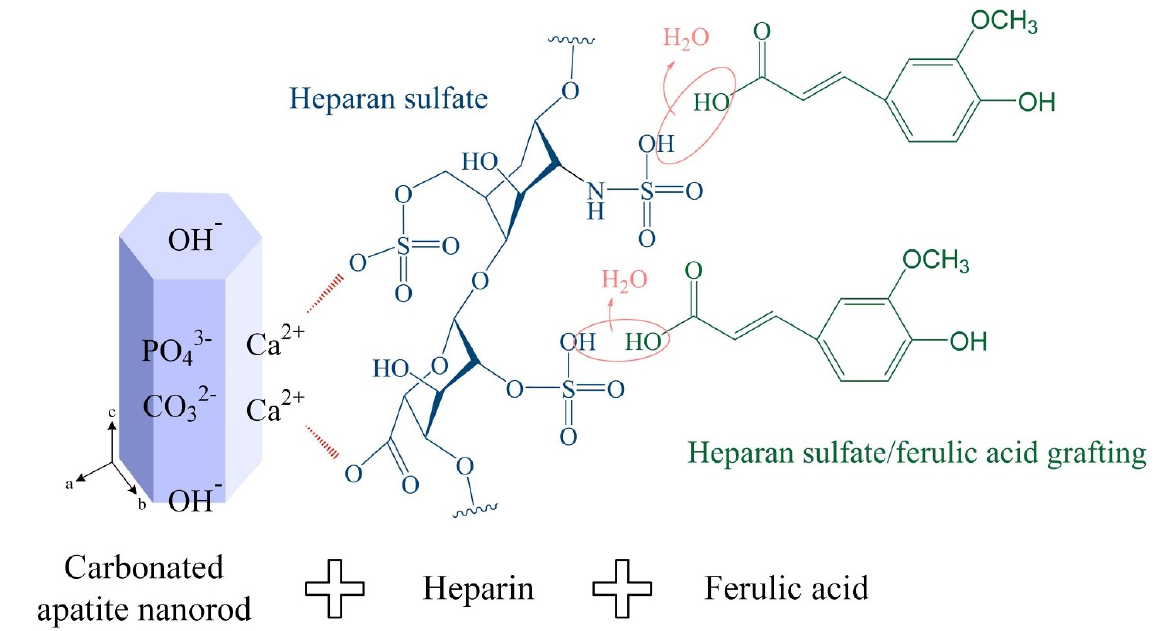
Figure 4. Possible grafting mechanism of polarized heparin-templated carbonated apatite nanorods grafted with ferulic acid.